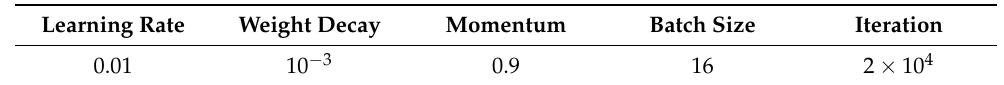
Table 3. Parameter